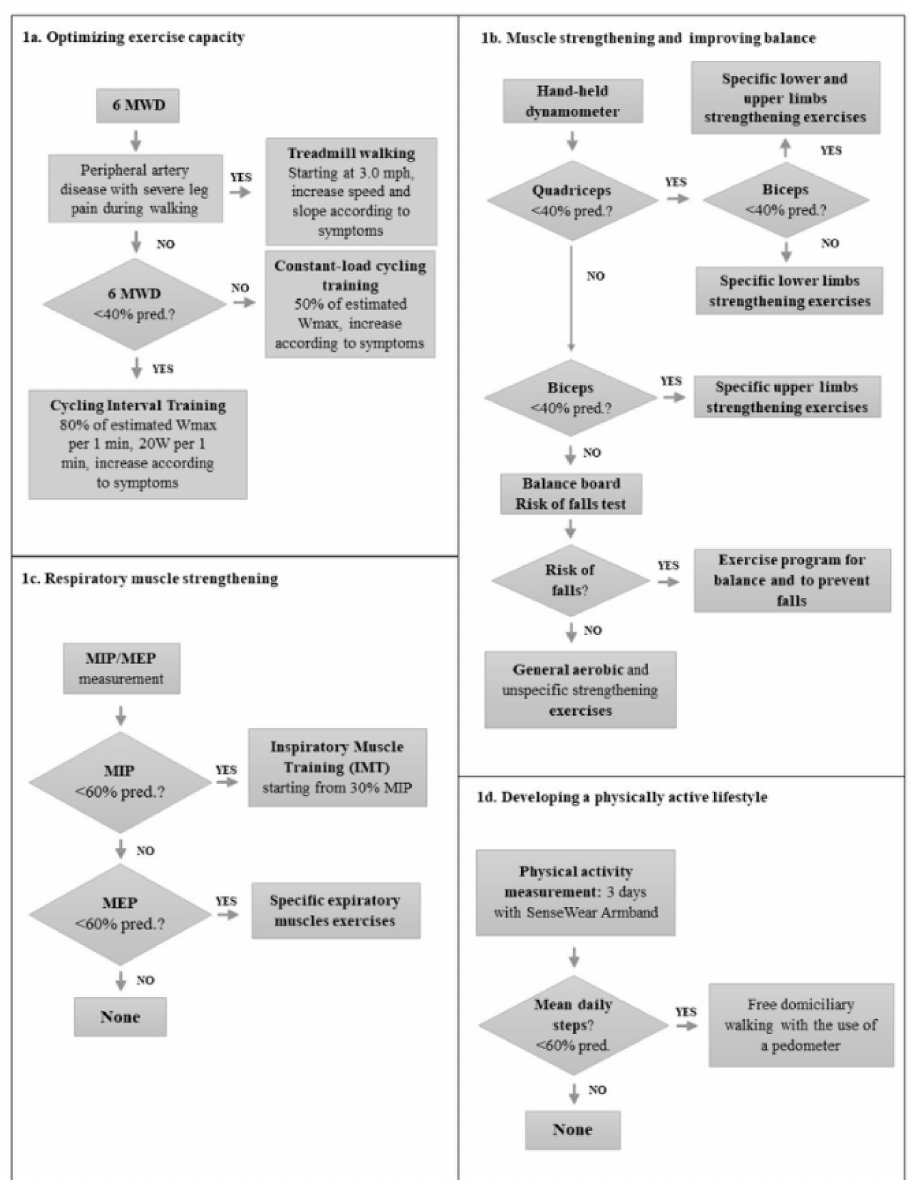
Figure 1. The algorithm developed in the audit process and used as a guide to train subjects with heart and lung diseases. 6MWD: 6-min Walk Distance; MEP: Maximal Expiratory Pressure; MIP: Maximal Inspiratory